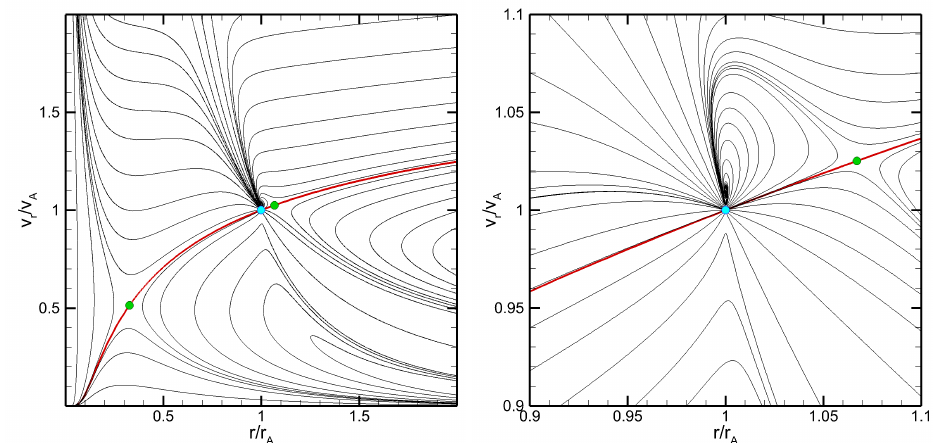
Figure 2. Integral curves corresponding to various types of solutions for the magnetohydrodynamic stellar wind. Critical points are shown as circles. The Alfvén critical point has coordinates (1, 1). The bold line corresponds to the solution passing through all three critical points. The right diagram shows the vicinity of the Alfvén